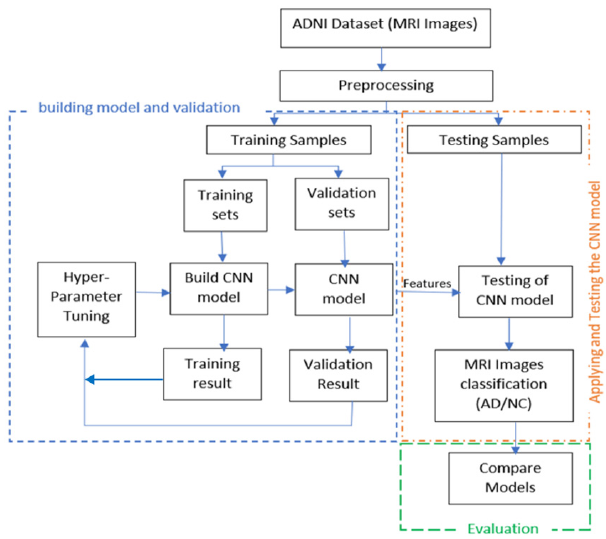
Figure 2. The detailed steps of the proposed